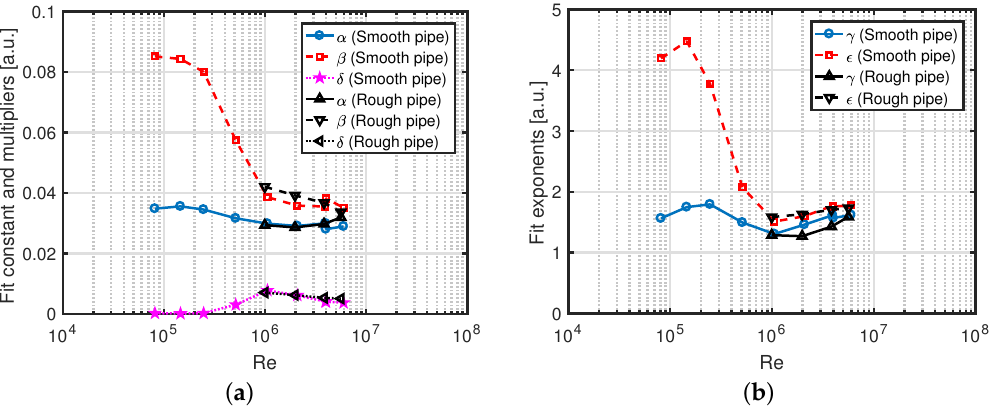
Figure A1. Comparison of smooth- and rough-pipe fit parameters, ( a ): fit parameters α , β and δ ; ( b ): fit parameters γ and ε .